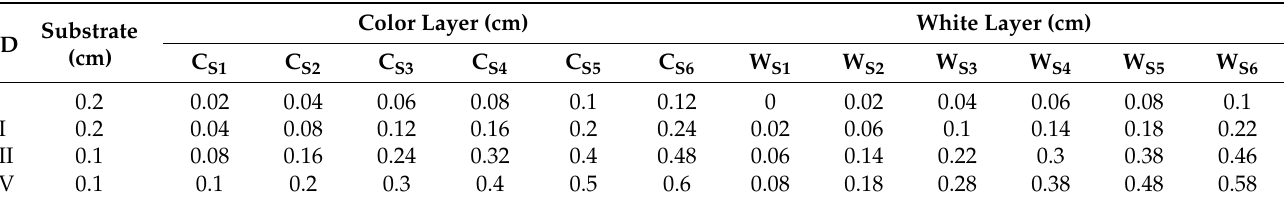
Table 2. Thickness parameters in each 3D test